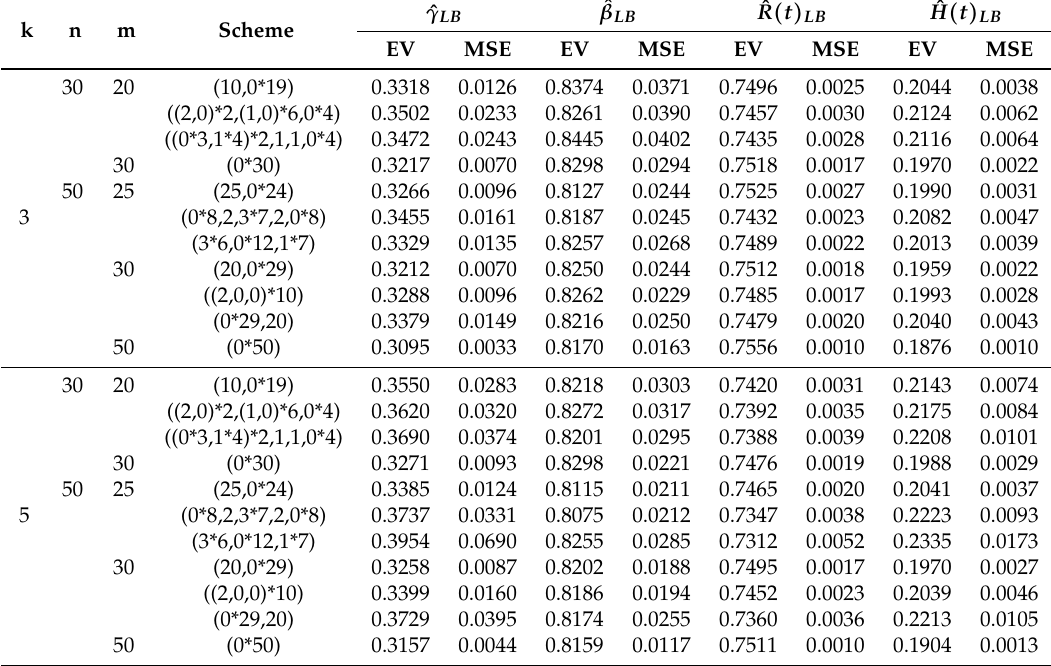
Table 3. Lindley approximation values and MSEs of parameters and reliability and hazard functions under SELF using noninformative priors when γ = 0.3, β = 0.8, t = 1.5, a 1 = 0, b 1 = 0, a 2 = 0, b 2 =